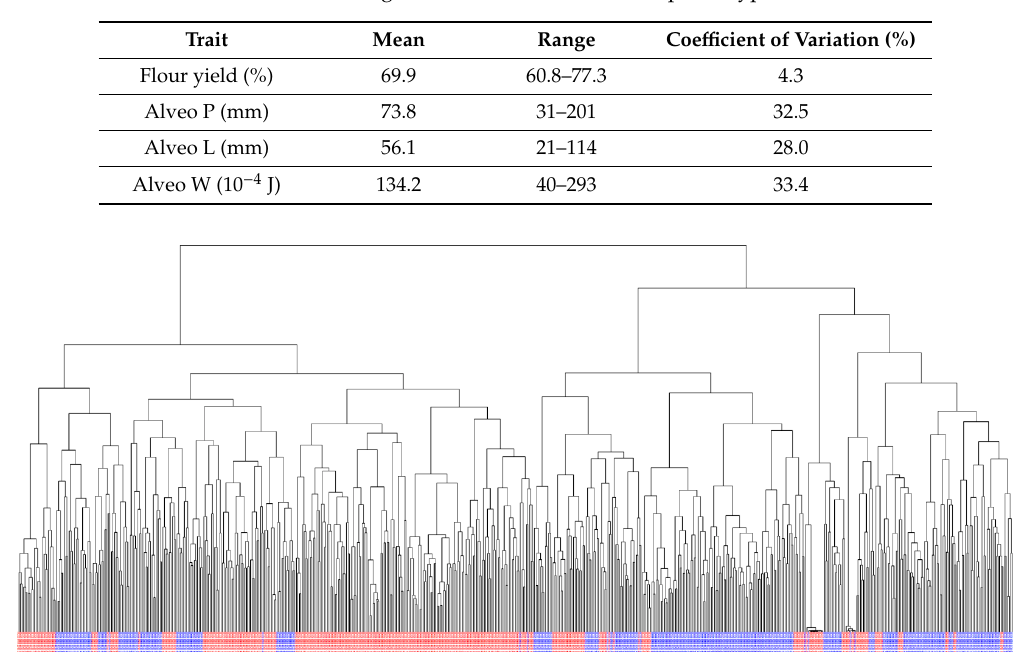
Figure 2. Dendrogram of the 635 wheat lines based on the G-matrix. Lines from set2014 are shown in red and lines from set2015 are shown in blue.